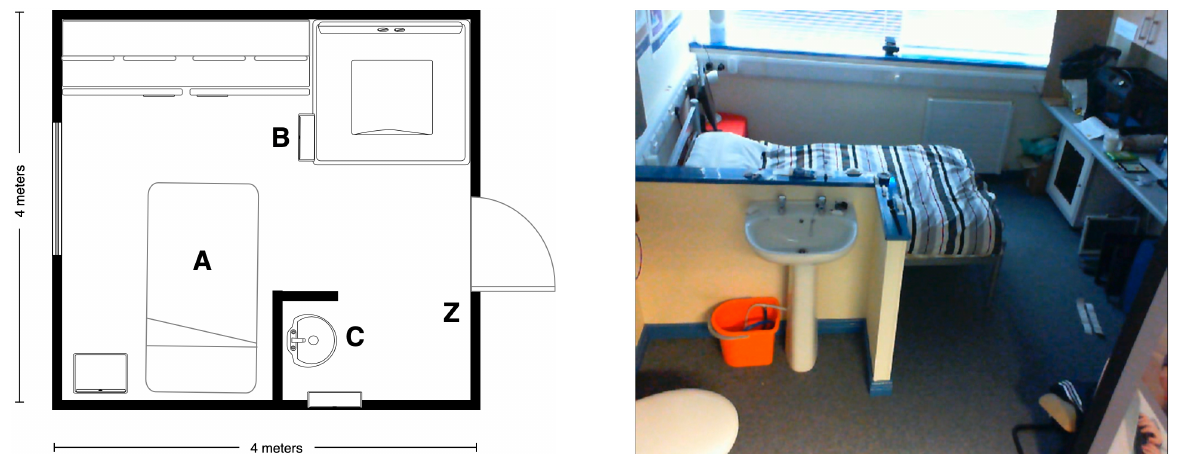
Figure 2. Sketch and photograph of the bedroom. The photograph was taken from position Z.